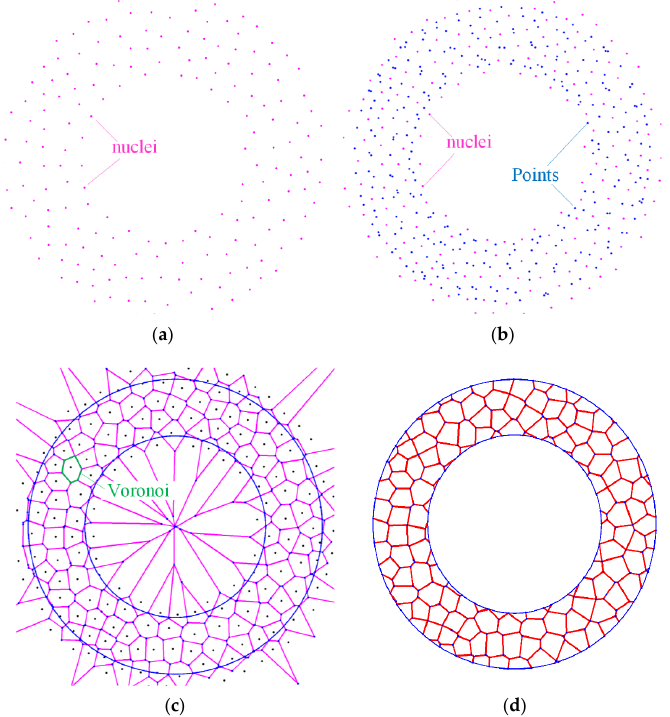
Figure 11. Generated nuclei and constructed Voronoi structure. ( a ) nuclei in given spaces; ( b ) Delaunaytriangulation and Voronoi diagram; ( c ) Voronoi structure. ( d ) foam core achieved.